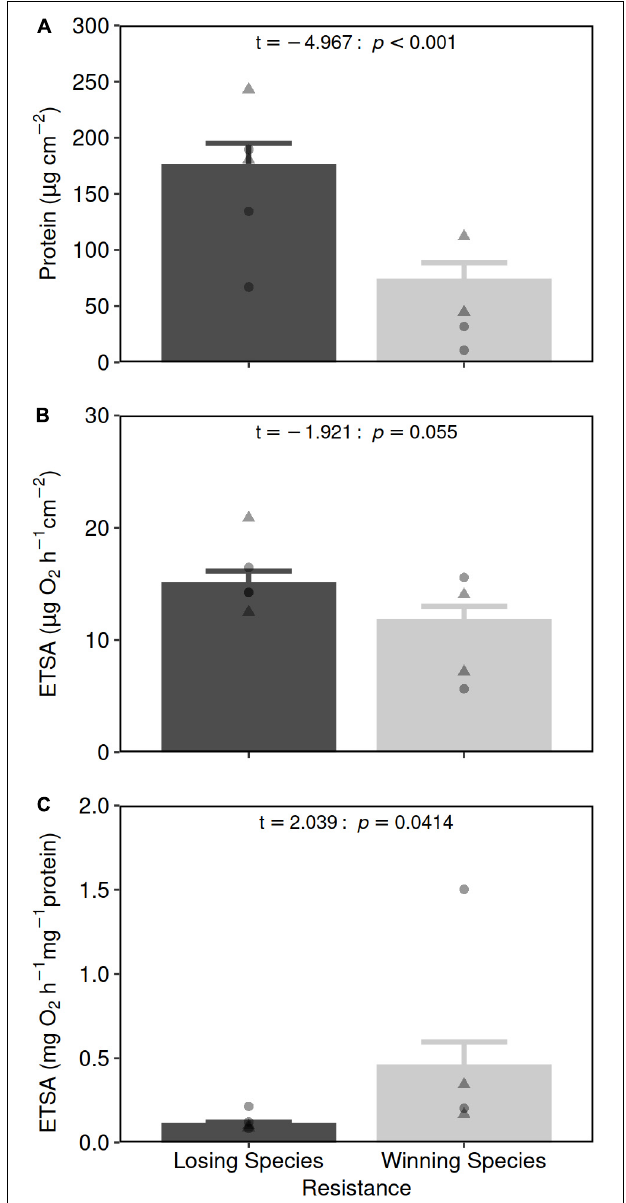
FIGURE 2 | Protein per surface (A) , ETSA per coral surface area (B) and ETSA per protein contents (C) (mean ± SE) in losing (black bars, sensitive to OA, n = 26) and winning coral species ( gray bars, resistant to OA, n = 21), collected in the control areas. Individual points show the mean value per species with circles for species from the Normanby site and triangles for species from the Shikine site (see Supplementary Table 1 ). Two-way GLMM (Resistance with Location as a random factor) results are presented in the top-right of each panel (see Supplementary Table 2 for more detailed